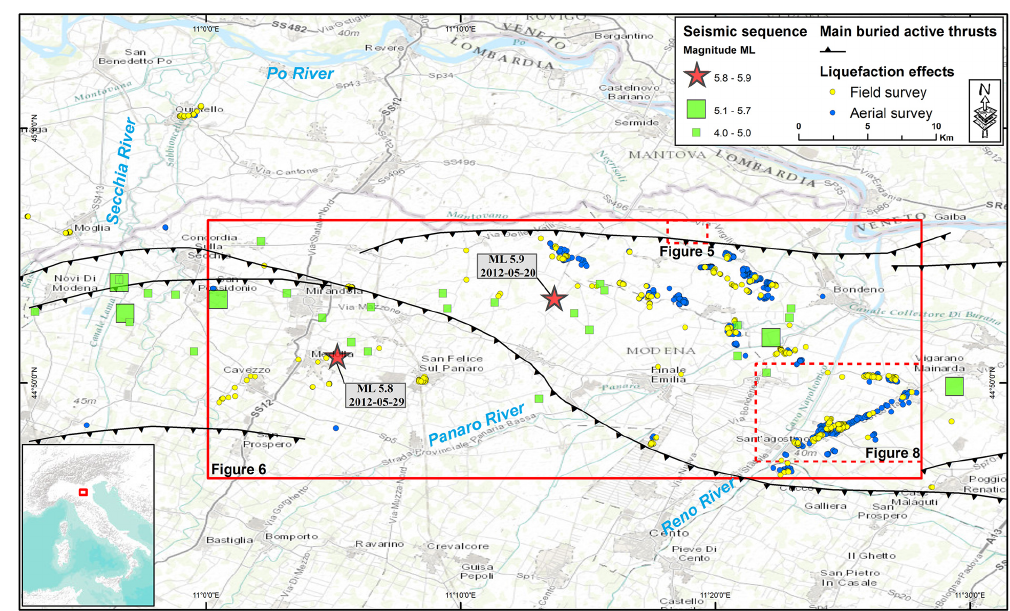
Figure 1. Area of the 2012 Emilia earthquake sequence: red stars locate mainshocks; large green squares locate five M ≥ 5.1earthquakes; small green squares locate M4.0< × <5.0earthquakes; main buried thrusts from Boccaletti and Martelli (2004); red rectangles locate Figs. 5, 6 and 8. Liquefaction effects recognized from field (yellow dots) and aerial (blue dots) surveys are